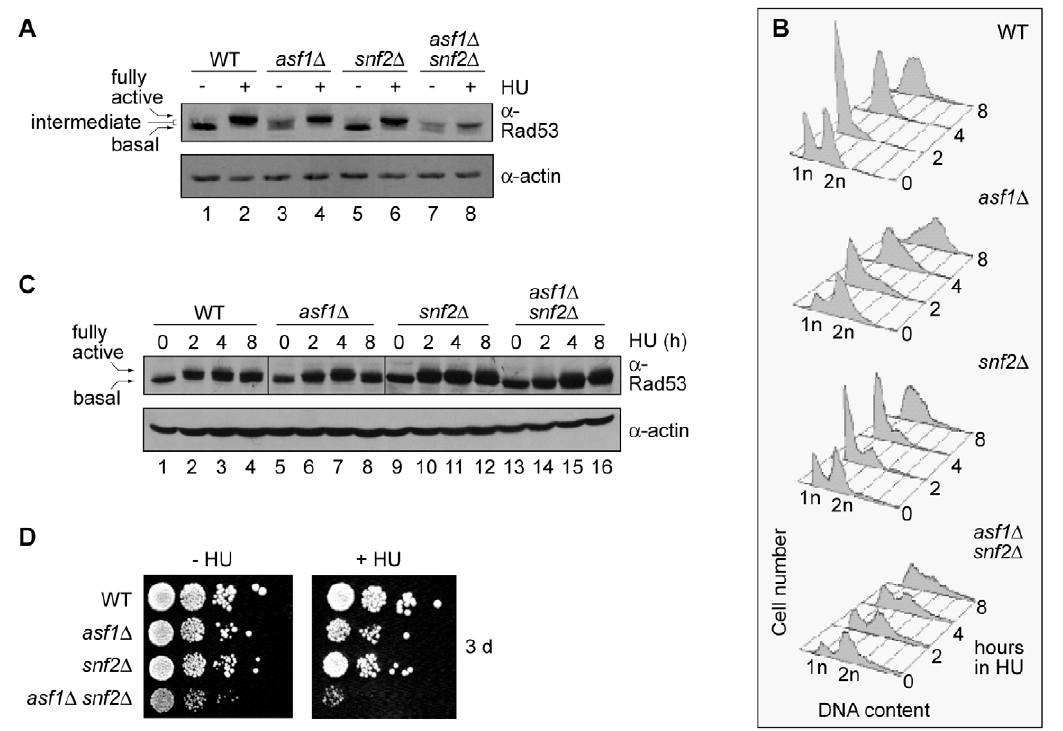
Figure 7. Asf1 and Snf2 have partially overlapping functions in cell cycle and checkpoint control. A. Rad53 activation is impaired in asf1 D snf2 D double mutants. Cells were grown in the presence or absence of 0.2 M HU for two hours. Actin is the loading control. The apparent lower expression of Rad53 in the double mutant was not reproducible – see Figure 7B. B. asf1 D snf2 D mutants fail to fully arrest in S phase in response to HU. DNA content of normally cycling cells (time 0) and cells grown in the presence of 0.2 M HU. C. Rad53 activation is delayed in asf1 D snf2 D double mutant cells. Cells from the cultures assayed in B were processed for analysis of Rad53 modification state. Actin is the loading control. D. Recovery from replication stress is compromised in asf1 D snf2 D mutants. Ten-fold serial dilutions of early log phase cells were grown in YPD or YPD + 0.2 M HU for 24 hours. Aliquots of these cultures were then diluted to 1 6 10 6 cells/mL and spotted onto rich solid medium. Cells were grown at 30 u C and photographs were taken after 2 and 3 days. doi:10.1371/journal.pone.0021633.g007 that asf1 D snf2 D cells are impaired for derepression of the DDR Table 1. Strains used in this study. genes because of a cell cycle defect that hampers engagement of replication stress checkpoint signalling. Strain